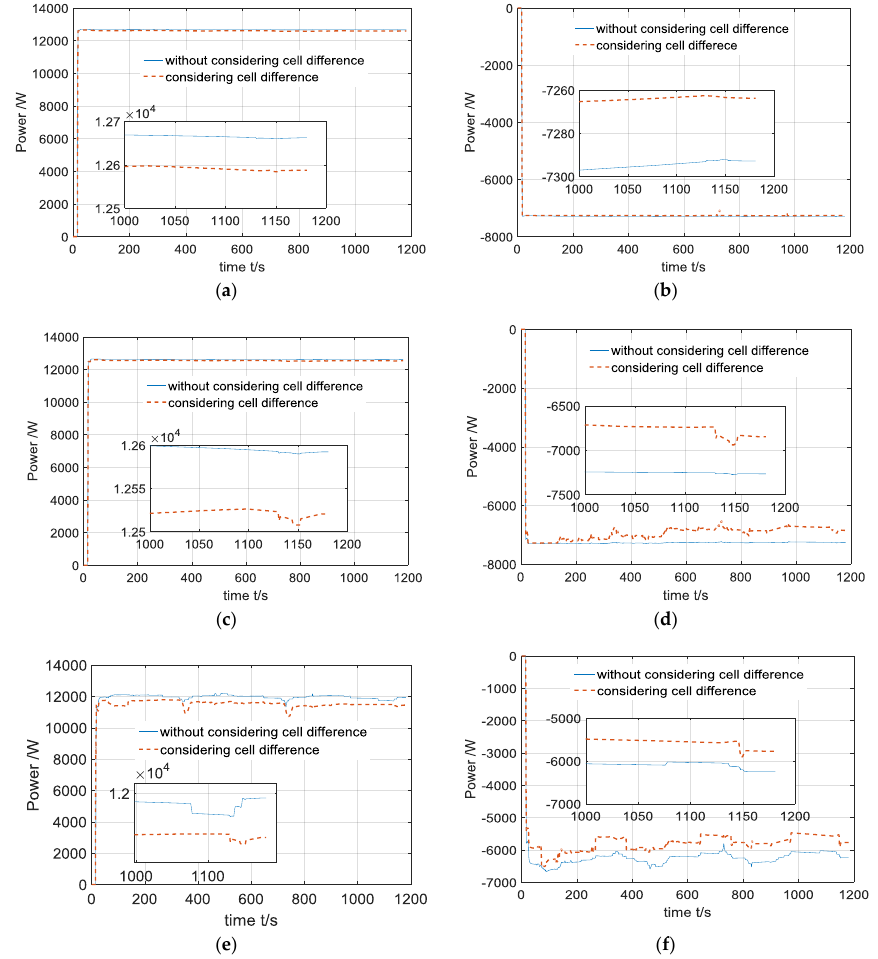
Figure 12. Power estimation results under the NEDC cycle test: ( a ) 1 s discharge power estimation result; ( b ) 1 s charge power estimation result; ( c ) 10 s discharge power estimation result; ( d ) 10 s charge power estimation result; ( e ) 30 s discharge power estimation result; and ( f ) 30 s charge power estimation result.